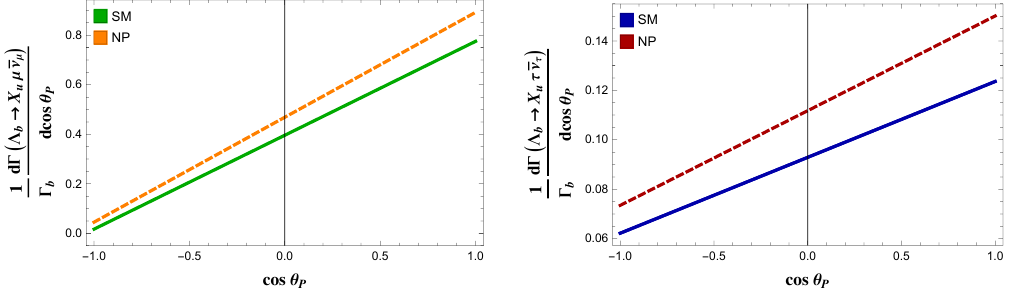
d (cid:0) for (cid:3) b ! X u ‘ (cid:22) (cid:23) ‘ , with ‘ = (cid:22) (left) and ‘ = (cid:28) (right). The (cid:0) b d cos (cid:18) P